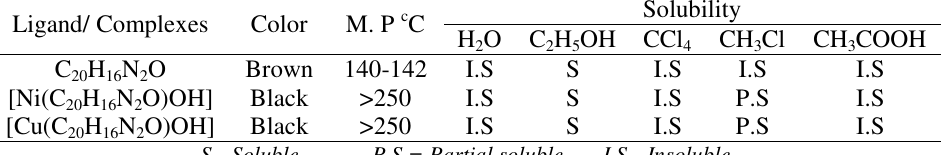
Table 1. Some physical properties of the ligand and its complexes with Ni(II) and Cu(II) ions. Ligand/ Complexes